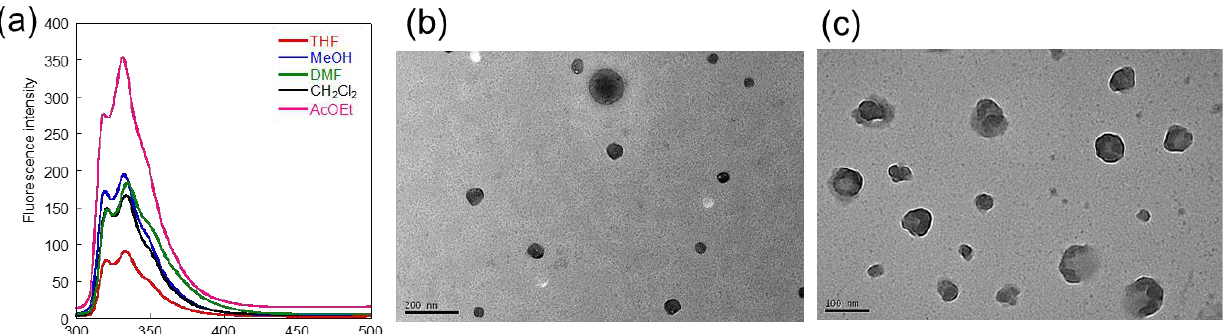
Figure 2. ( a ) Fluorescence spectra of NP(Fl) in different organic solvents (conc. = 0.001 mg/mL), and TEM images of NP(Fl)s prepared using ( b ) ethyl acetate and ( c ) THF solutions. TEM images of NP(Fl)s prepared using ( b ) ethyl acetate and ( c ) THF